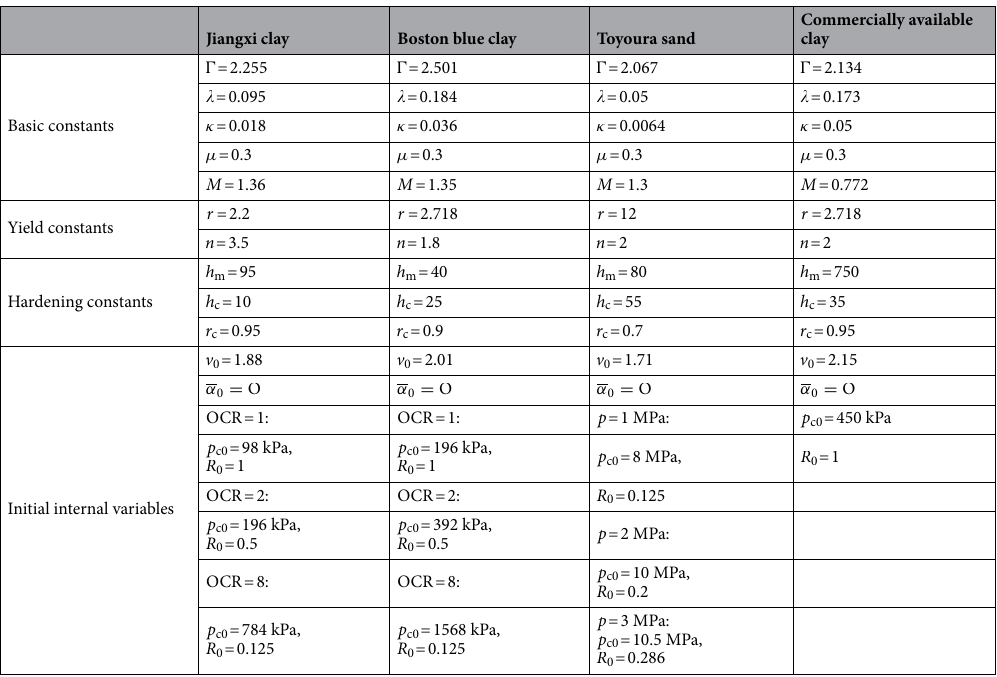
Table 4. The material constants of different samples.